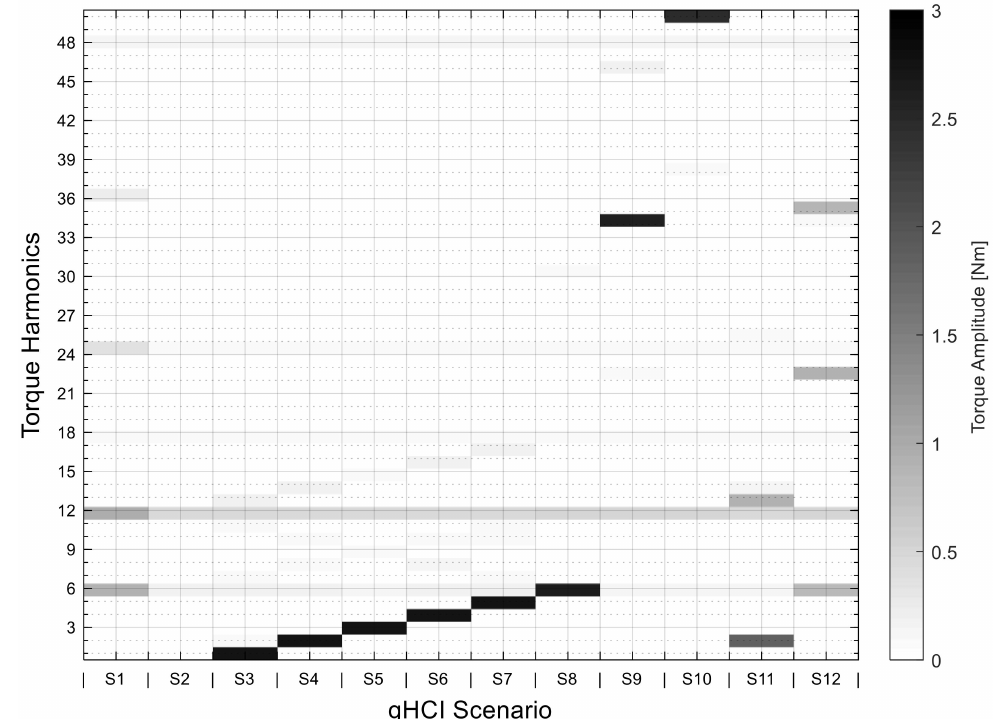
Figure 6. Results of the Fourier transformed torque ripple of the 12 generative harmonic current injection (gHCI) scenarios of machine